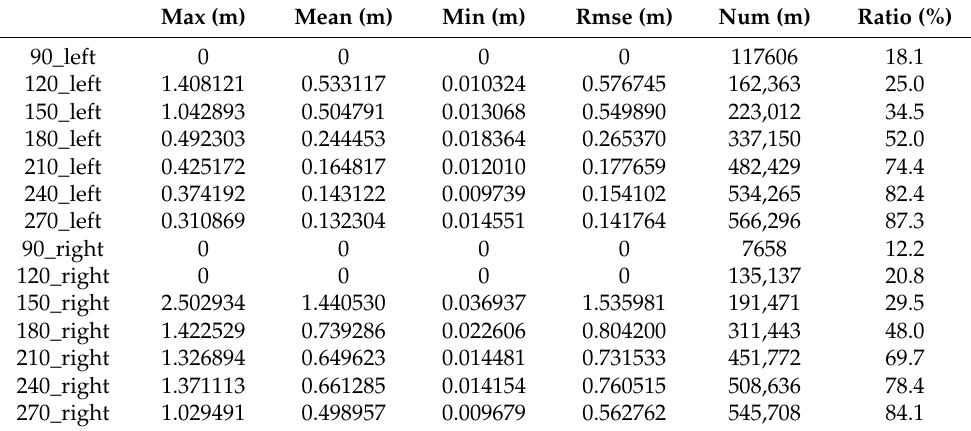
Table 2. Absolute trajectory error left and right.